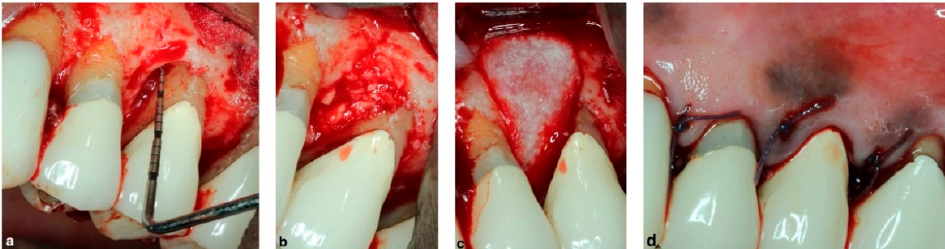
Figure 1. Guided tissue regeneration using a resorbable membrane: ( a ) soft tissue flap reflected, intra-osseous defect; ( b ) bone graft placed in intra-osseous defect; ( c ) resorbable collagen membrane placed over bone graft; and ( d ) soft tissue flap placed and sutured over membrane.